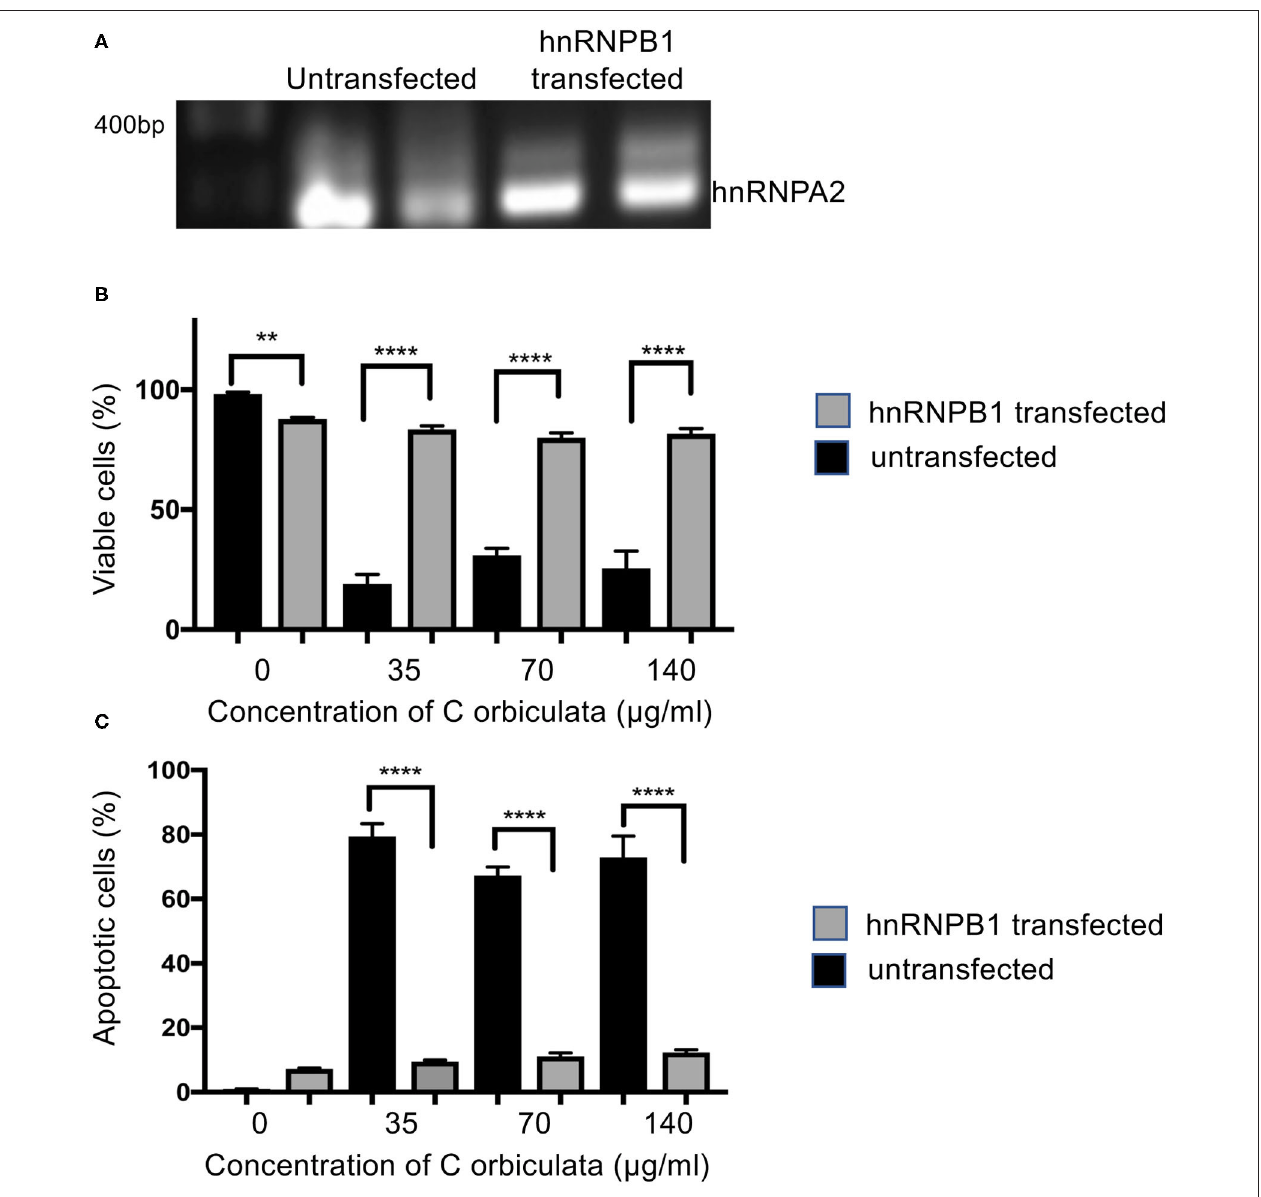
FIGURE 6 | Overexpression of hnRNPB1 counteracts the effects of C. orbiculata . (A) Cells were transfected with 2 µ g plasmid expressing hnRNPB1 cDNA and then RNA was extracted and subjected to RT-PCR. Cells were subjected to treatment with C. orbiculata for 48h and then subjected to Annexin V/PI flow cytometry. (B) The proportion of viable cells was slightly lower in untreated cells transfected with hnRNPB1 plasmid. However, when treated with C. orbiculata extract there was a much reduced decrease in viability compared with untransfected cells. (C) The proportion of apoptotic cells was significantly reduced by transfection with hnRNPB1. One-way ANOVA with Dunnett’s multiple comparison test and post-hoc test for trend was used, * P < 0.05, ** P < 0.01, *** P < 0.001, **** P <